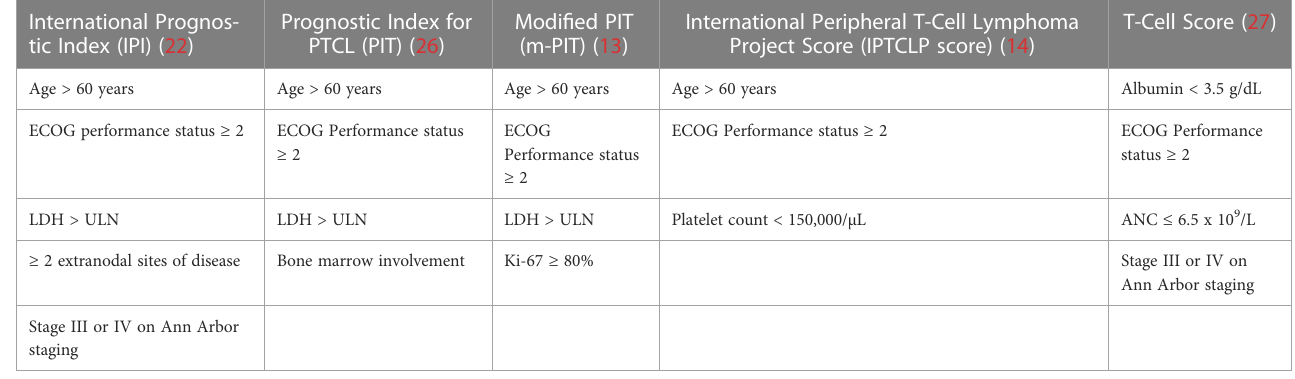
TABLE 1 Criteria for PTCL prognostic